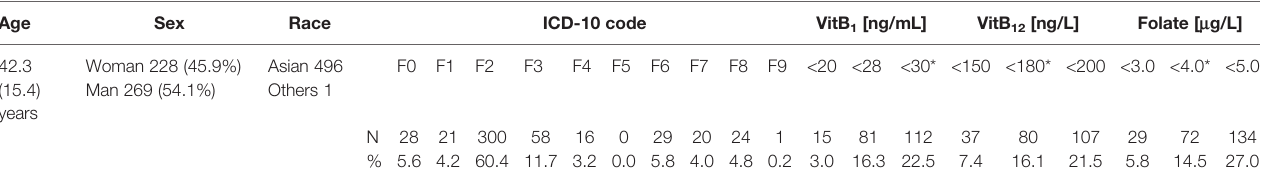
TABLE 1 | Patient distribution data (n =